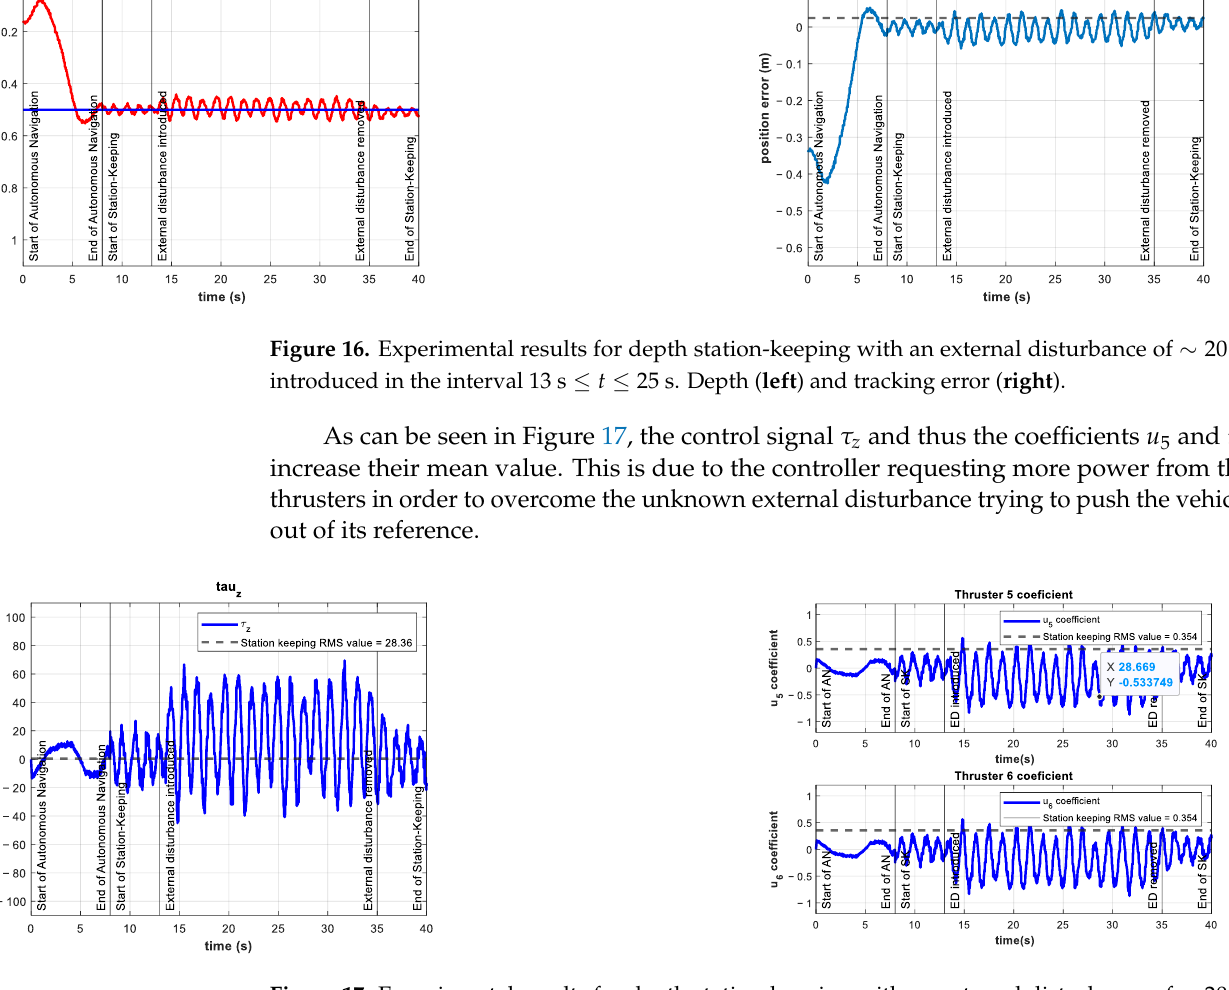
Figure 17. Experimental results for depth station-keeping with an external disturbance of ~20 N introduced in the interval 13 s ≤ t ≤ 25 s. Control signal τ z ( left ) and thruster coefficients u 5 , u 6 ( right ).